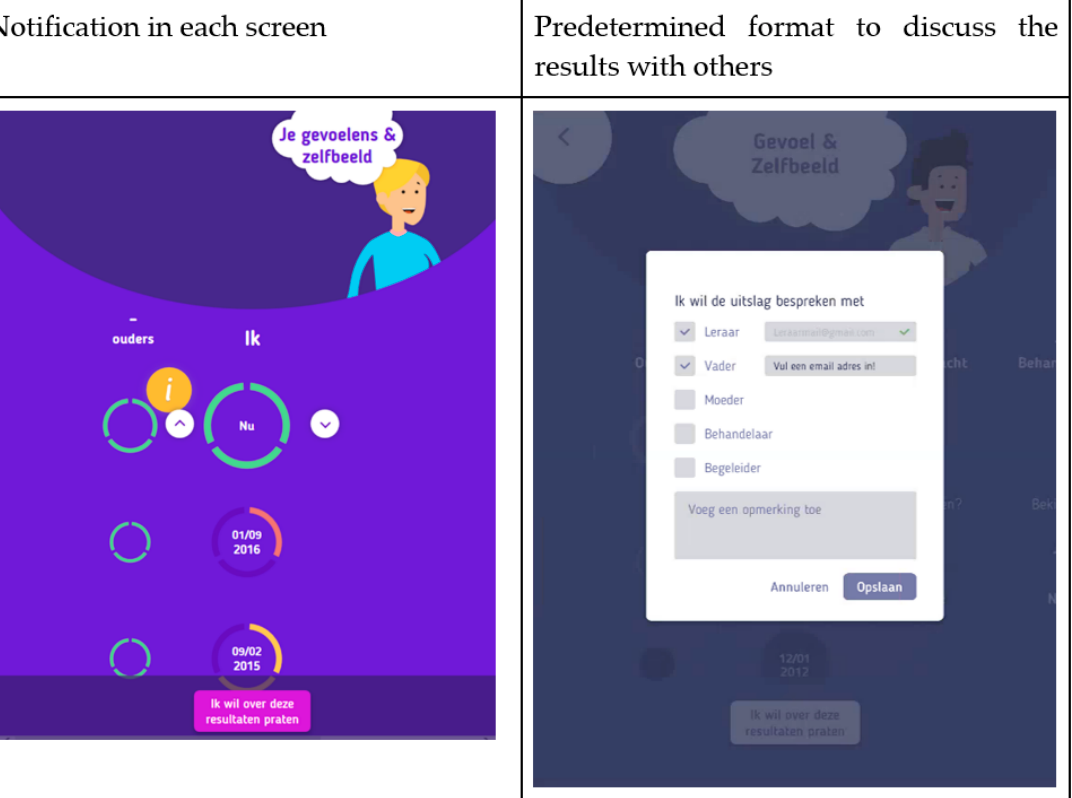
Figure 7. Notification ‘I want to discuss these results with others’.